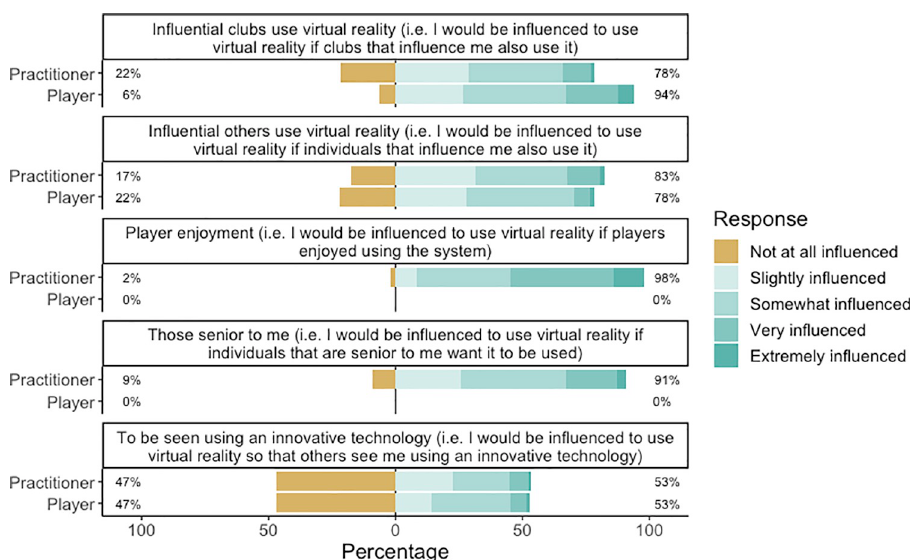
Fig 3. Responses by practitioners and players to statements on how they perceive they are influenced to use VR. Percentages indicate not at all influenced, and overall influenced, from left to right